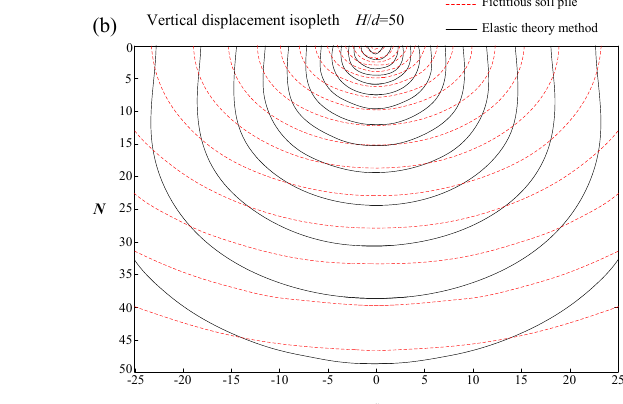
Figure 7. Category of the fictitious soil pile model: ( a ) Ref. [56]; ( b ) Ref. [63]; ( c ) Ref. [64]; ( d ) Ref.